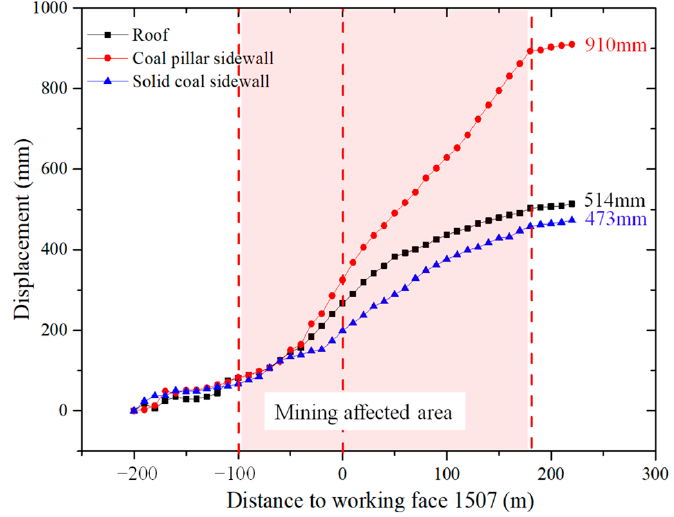
Figure 2. Surrounding rock deformation characteristics of ATR 1511 under mining disturbance of the adjacent working